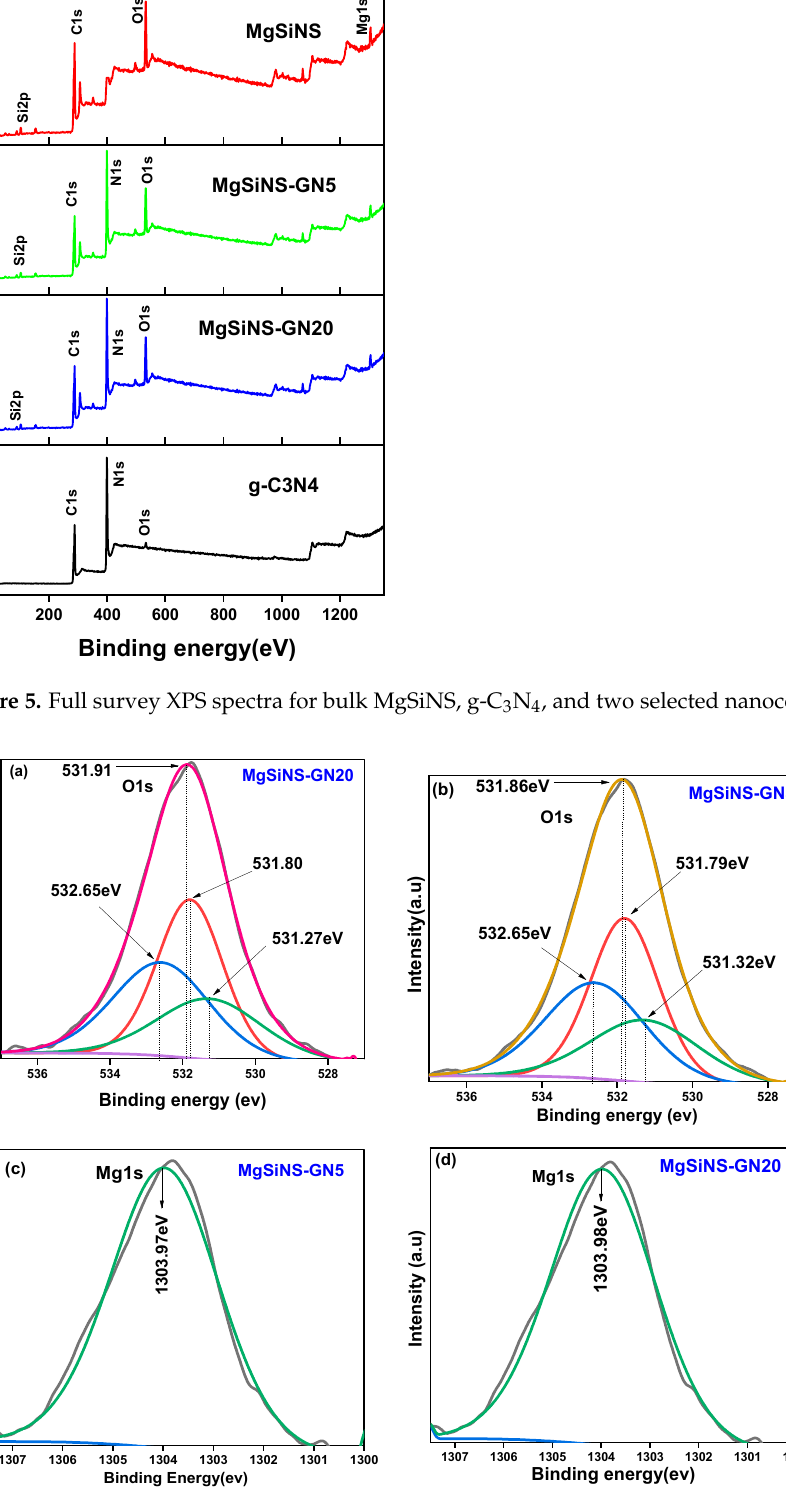
Figure 6. Deconvoluted XPS spectra for two selected nanocomposites O 1s of ( a ) MgSiNS-GN20 and ( b ) MgSiNS-GN5, and Mg 1s of ( c ) MgSiNS-GN5 and ( d ) MgSiNS-GN20.